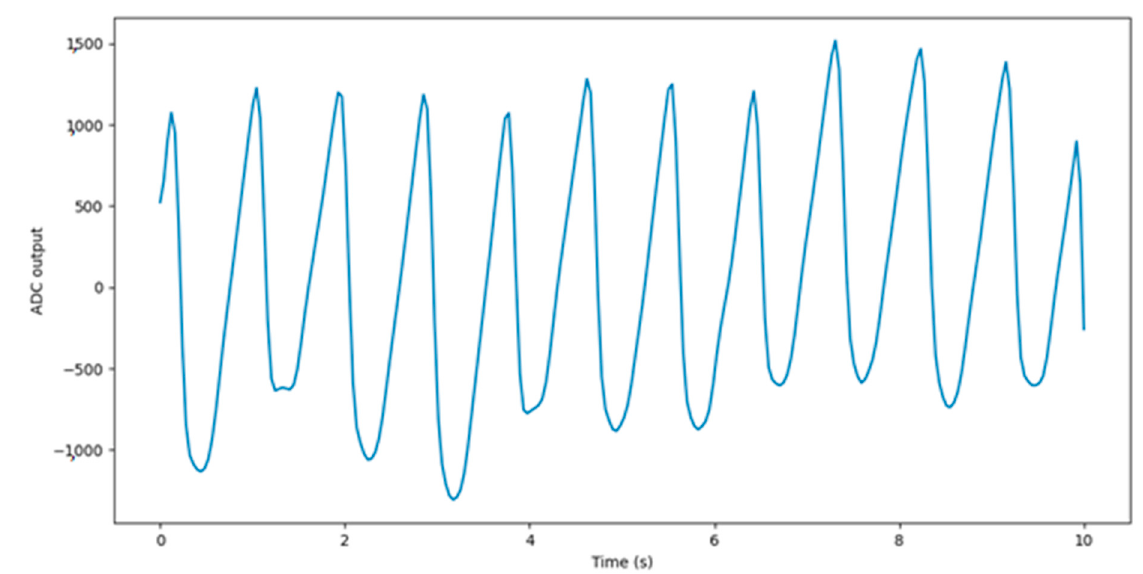
Figure 5. Filtered PPG signal.